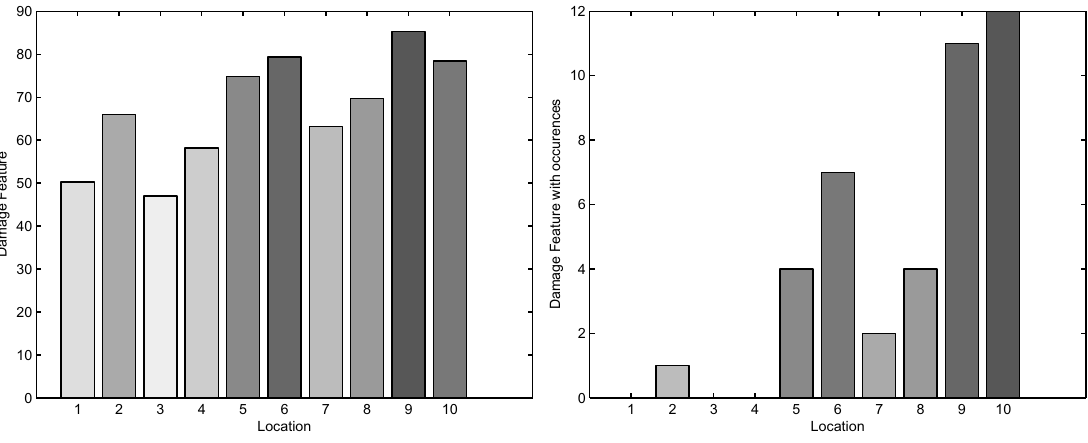
Fig. 38. Damage feature without and with occurrences for damaged structure and changing loading conditions, frequency range 25–30 Hz.